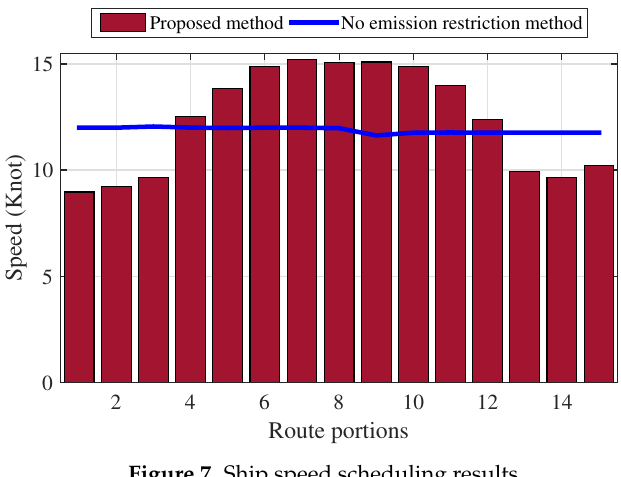
Figure 7. Ship speed scheduling results.